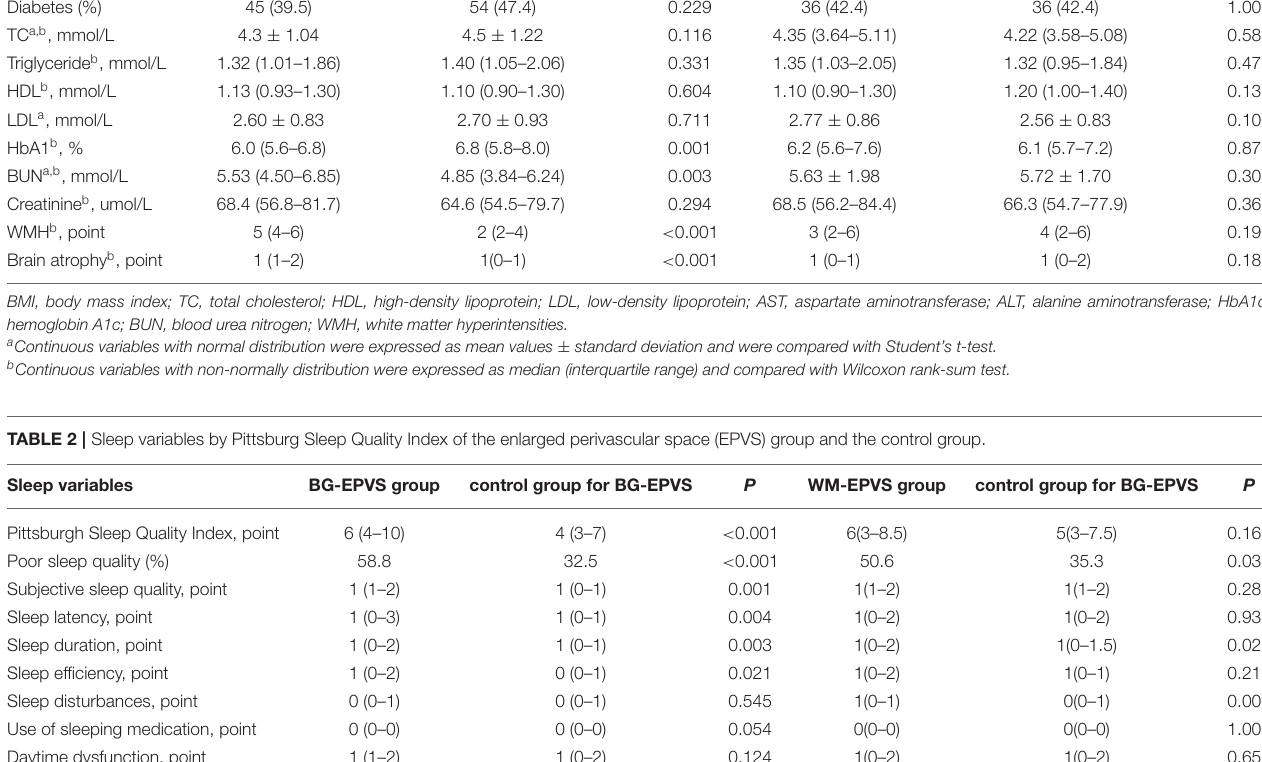
TABLE 3 | Results of the binary logistic regression analysis between sleep quality and enlarged perivascular spaces in basal ganglia (BG-EPVS).